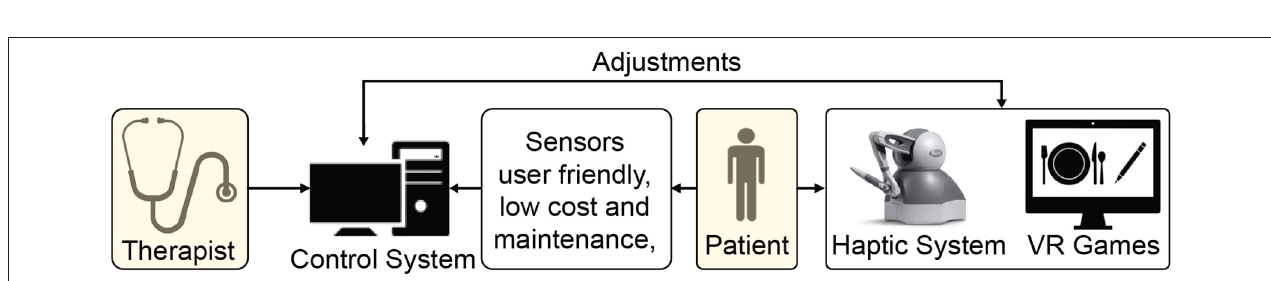
FIGURE 3 | Schematic demonstrating a haptic device and virtual reality (VR)-based home rehabilitation setup.